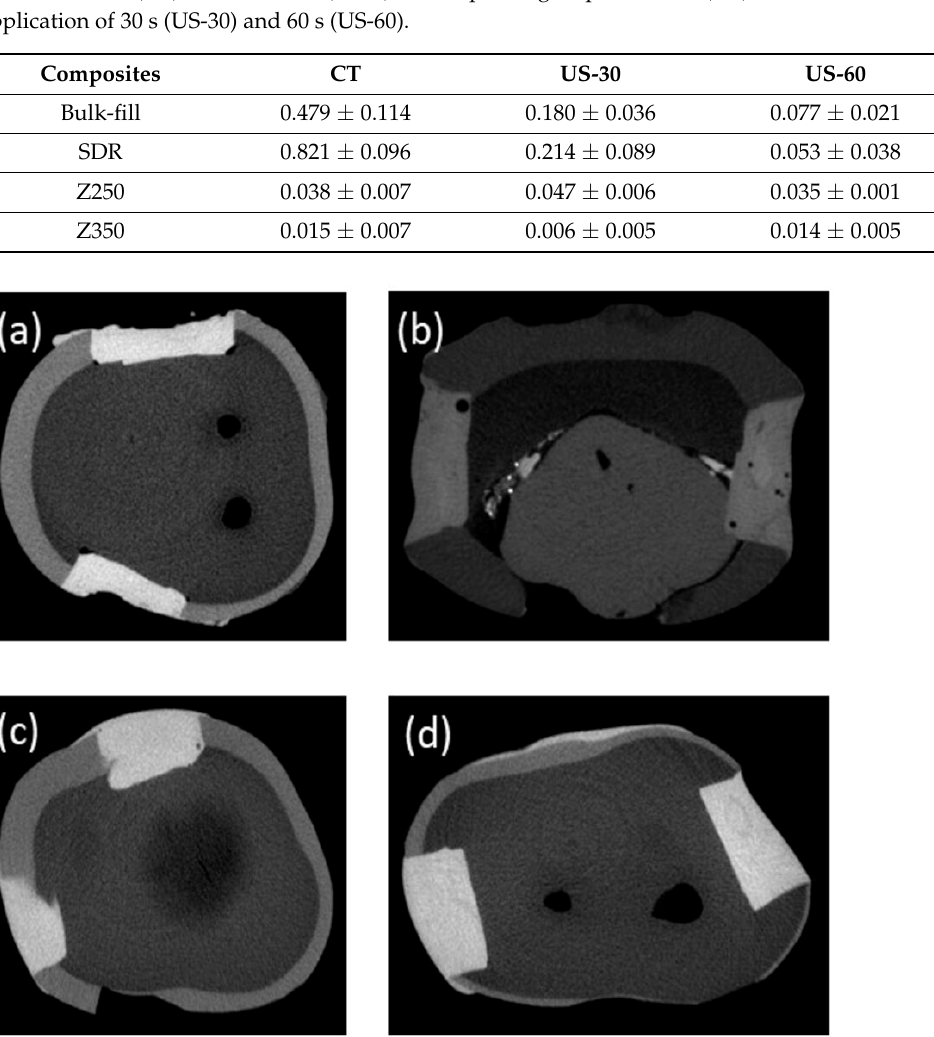
Figure 9. Micro-CT images showing representative samples of ( a ) Filtek Bulk-fill, ( b ) SDR, ( c ) Filtek Z250, and ( d ) Filtek Z350 after 60 s of ultrasonic activation. The images show presence of voids within the composite restorations, whereby SDR appears with maximum voids compared to the other